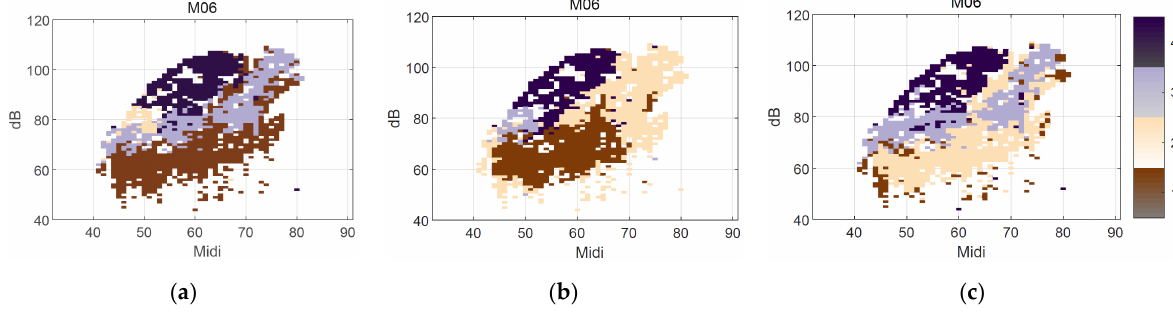
Figure 8. A classification that uses ( a ) all six metrics combined, ( b ) acoustic metrics only, and ( c ) EGG metrics only. Here, the acoustic metrics are the crest factor, CPPs, and SB, and the EGG metrics are the Q ci , Q ∆ , and CSE. The x -axis is f o in semitones (on the MIDI scale, 48 = 110 Hz), and the y -axis is SPL in dB(C) at 0.3 m.